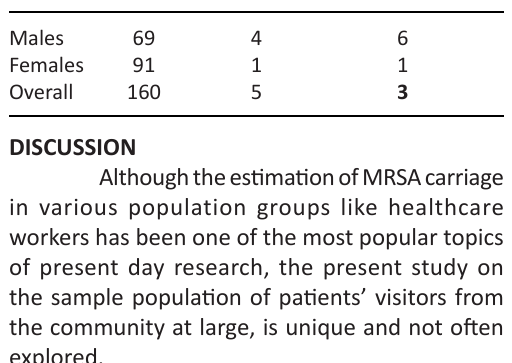
Table 2. Distribution of isolates Isolate No.